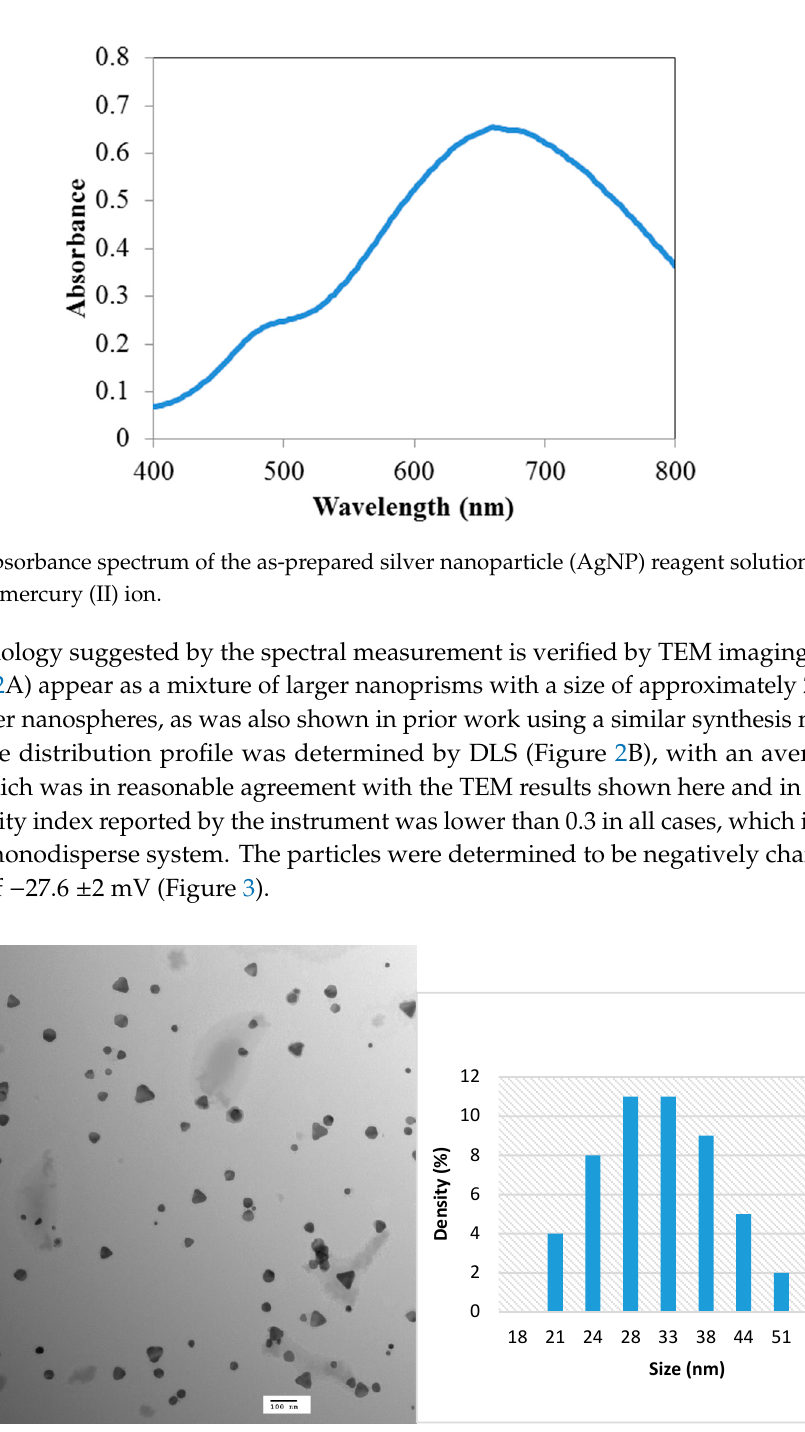
Figure 2. ( A ) TEM micrograph with 100 nm scale bar, and ( B ) particle size distribution profile of silver nanoparticles measured by dynamic light scattering (DLS).